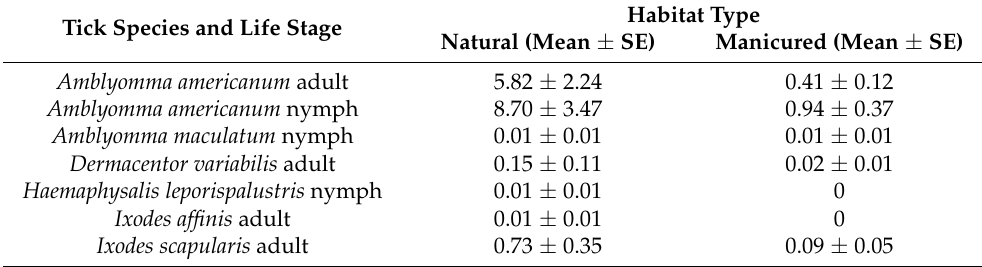
Table 1. Average density per 1 km 2 with standard error (SE) of nymphal and adult ticks collected by species, across each sampling bout from the first week of January 2021 to the last week of June 2021 and across location. Estimates are provided for two sampling site categories (9 natural sites and 9 manicured sites) in 17 greenspaces in Alachua County, Florida, USA. Zero indicates no ticks were